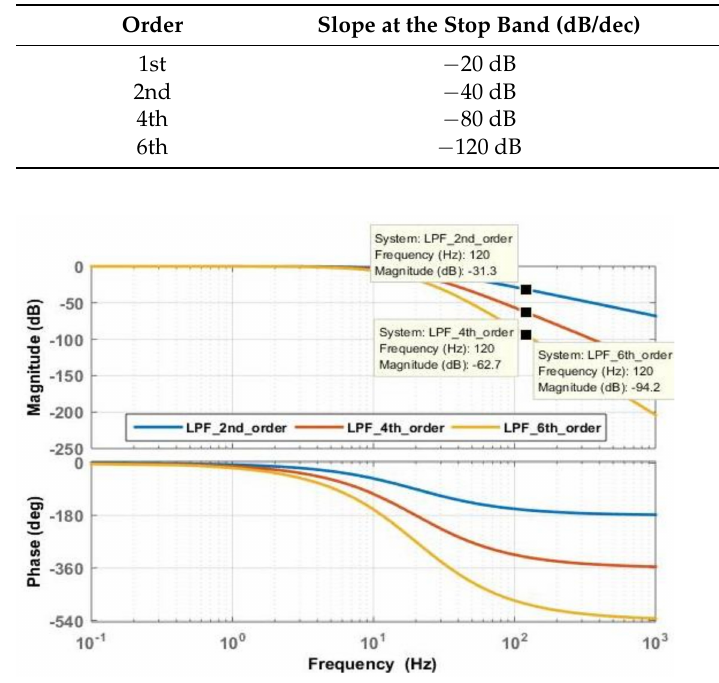
Table 1. Attenuation of the LPF with a different slope at the stop band.